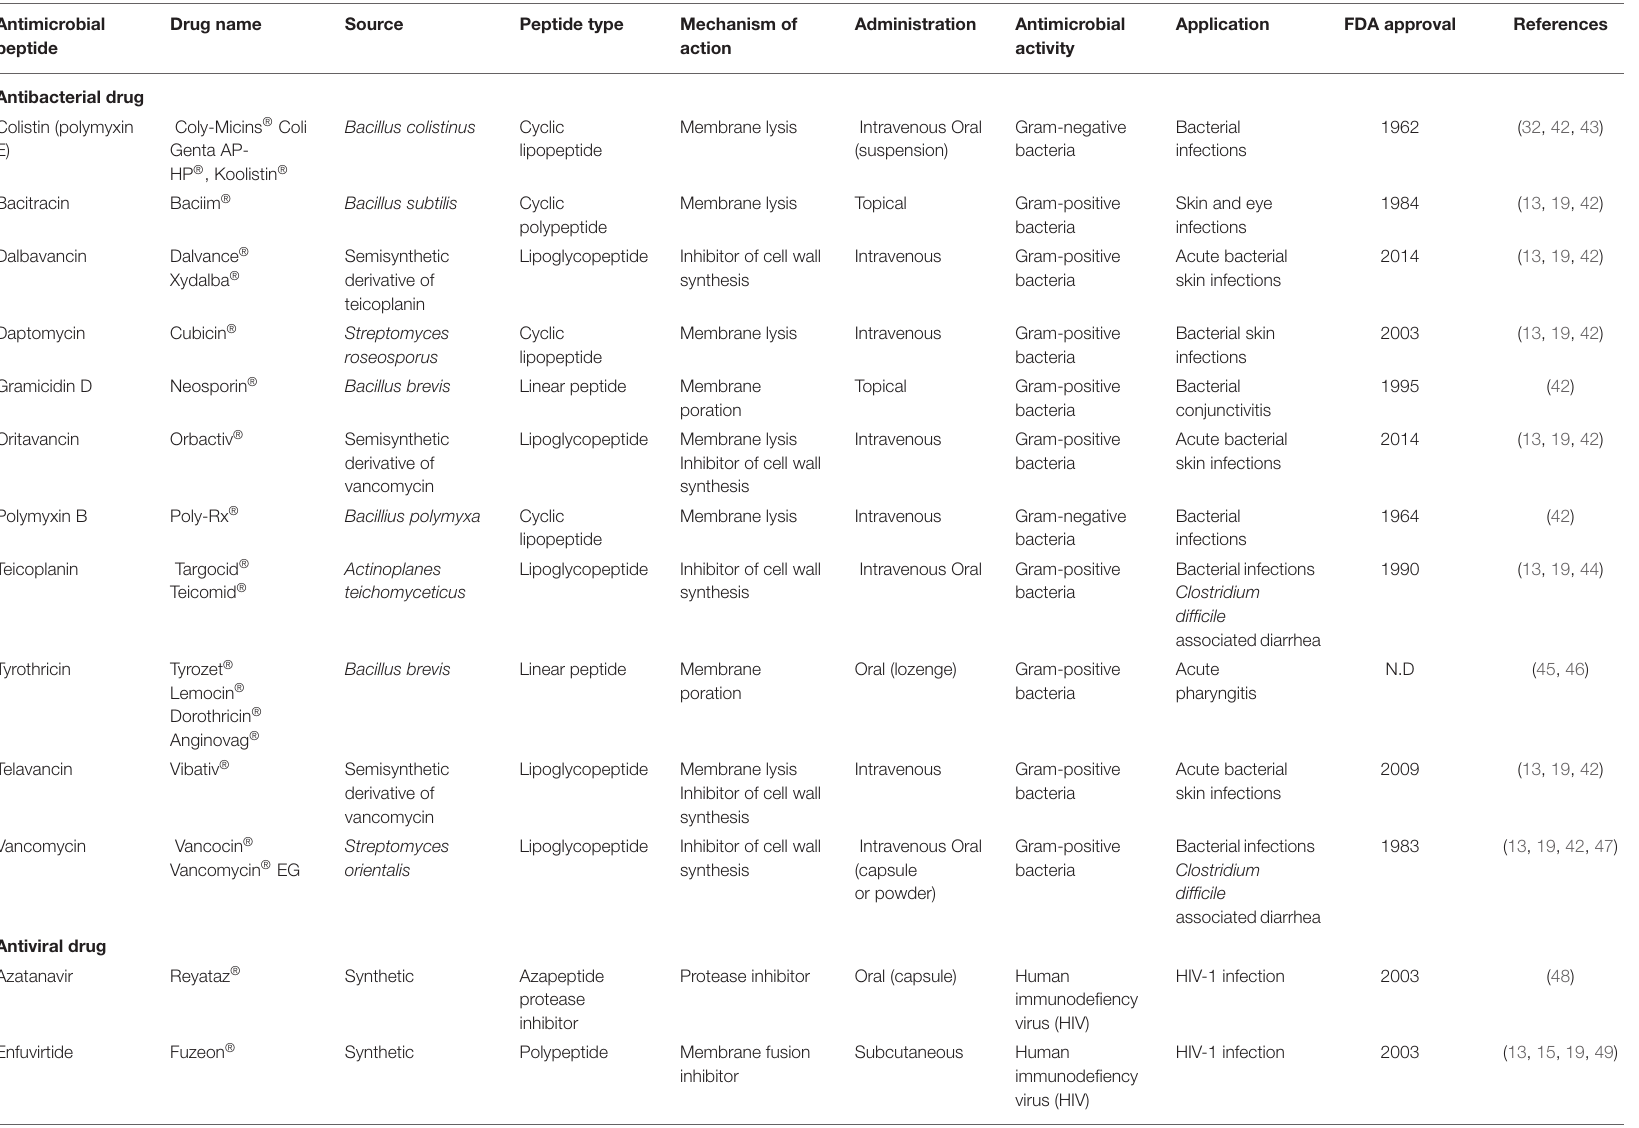
TABLE 1 | The antimicrobial peptide (AMP) drugs approved by the Food and Drug Administration (FDA). Antimicrobial